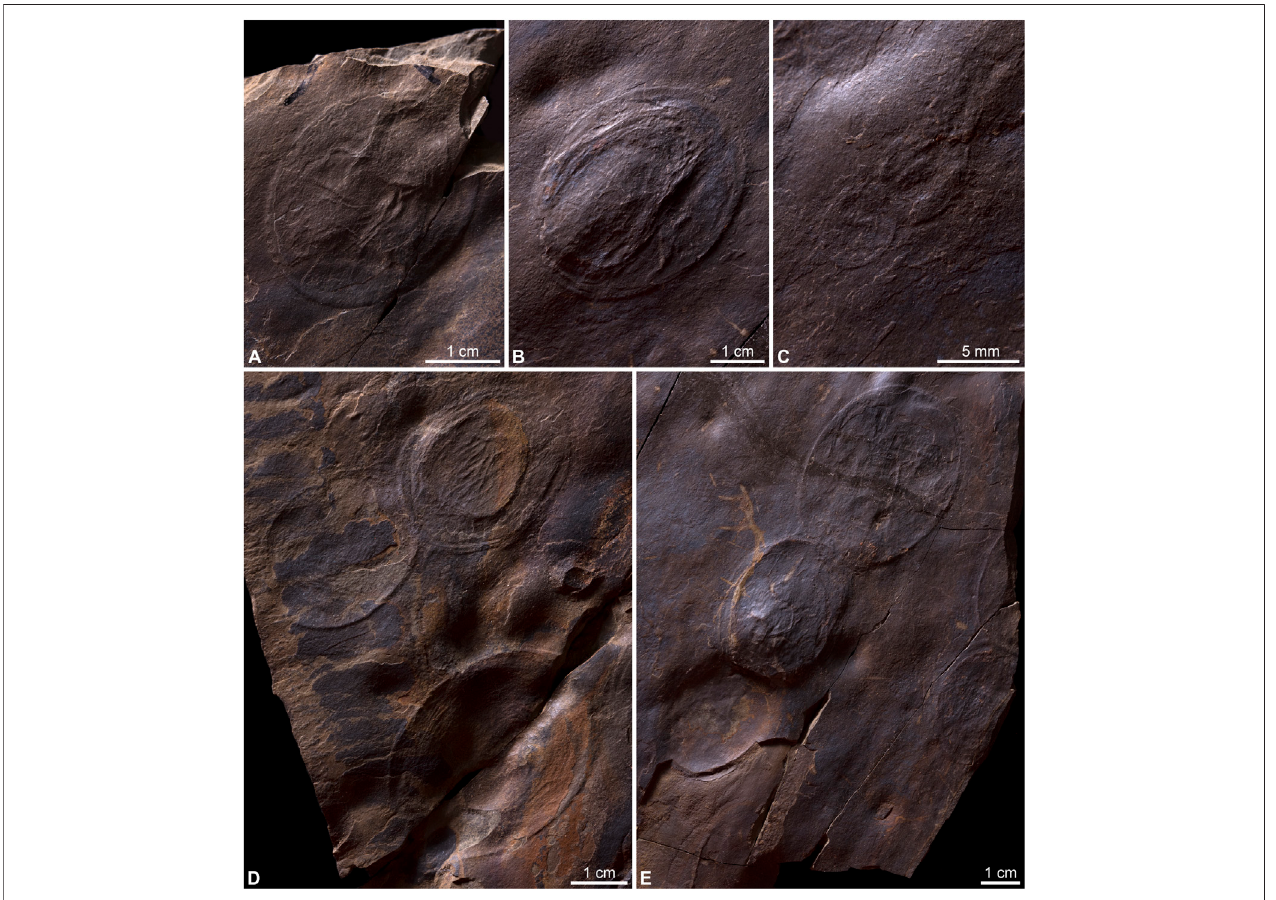
FIGURE 4 | Beltanelliformis konovalovi sp. nov. from the BS surface: (A) CU 2019/002, single specimen with radial wrinkles; (B) CU2019/001, holotype, single specimen with radial and concentric wrinkles; (C) CU2019/003, two small specimens adjoined to each other; (D) CU2019/005, (E) CU2019/006, single, paired, and clustered